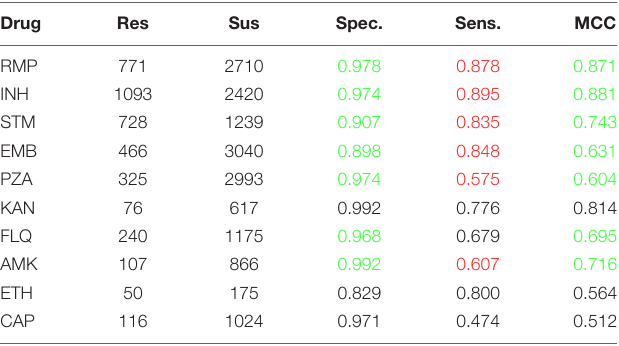
TABLE 6 | PointFinder predicted resistance compared with phenotypic drug susceptibility testing on the ReSeq data set after including premature stop codons and exclusion of non-predictive mutations.